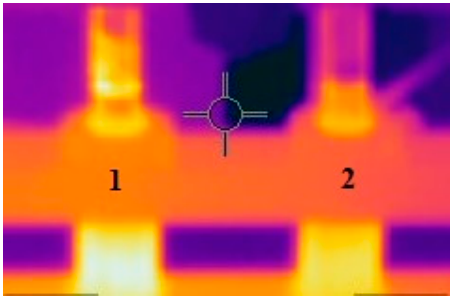
Figure 11. Temperature distribution tests in atomizers: ( 1 ) modified; ( 2 ) standard.